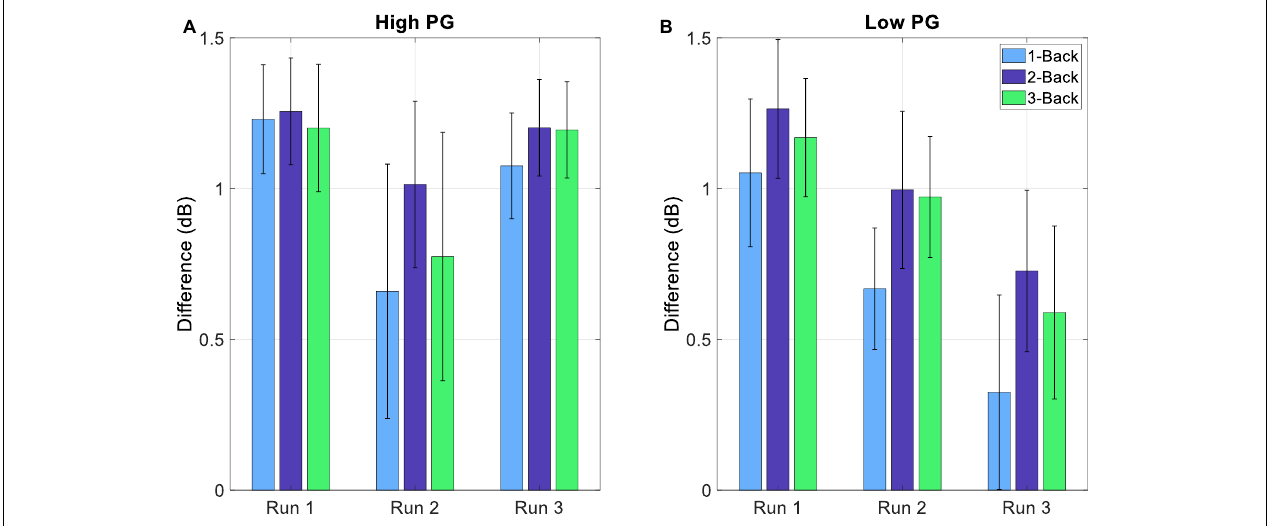
FIGURE 8 | Average difference (and SE) between the threshold (THRS – Eq. 8) and the standardized Riemannian distances of the task-run EEG (Eq. 7) and for the (A) high and (B) low PG.